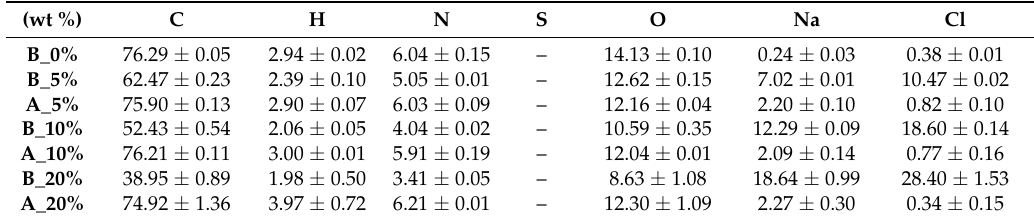
Table 2. Chemical composition of food-waste-derived biochar with different NaCl contents. (A: washed biochar; B: unwashed biochar; –: Not detected.).